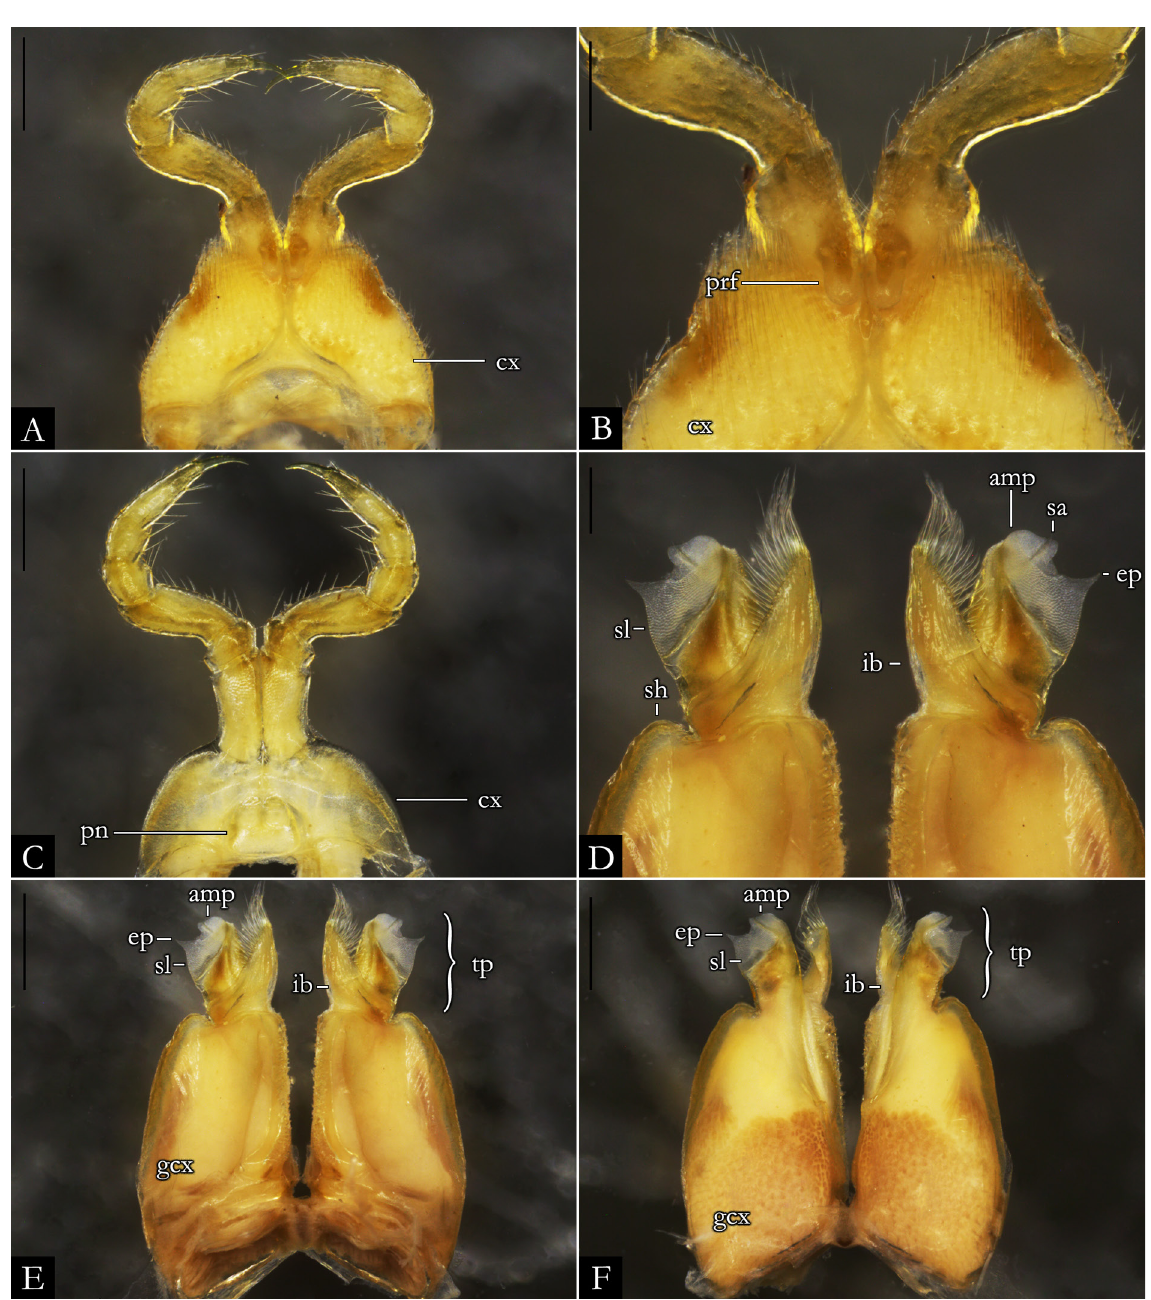
Fig. 96. Pseudonannolene microzoporus Mauriès, 1987, ♂ (IBSP 3427). A . First leg-pair. B . Detail of prefemur. C . Second leg-pair. D . Detail of telopodites, in anal view. E . Gonopods, in anal view. F . Gonopods, in oral view. Abbreviations: see Material and methods. Scale bars: A, C, E–F = 0.5 mm; B, D = 0.2